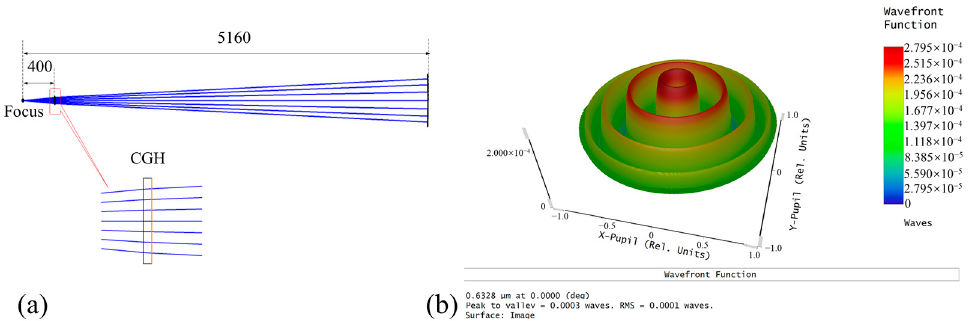
Figure 15. Design of the inspection optical path. ( a ) CGH compensator; ( b ) design wavefront.